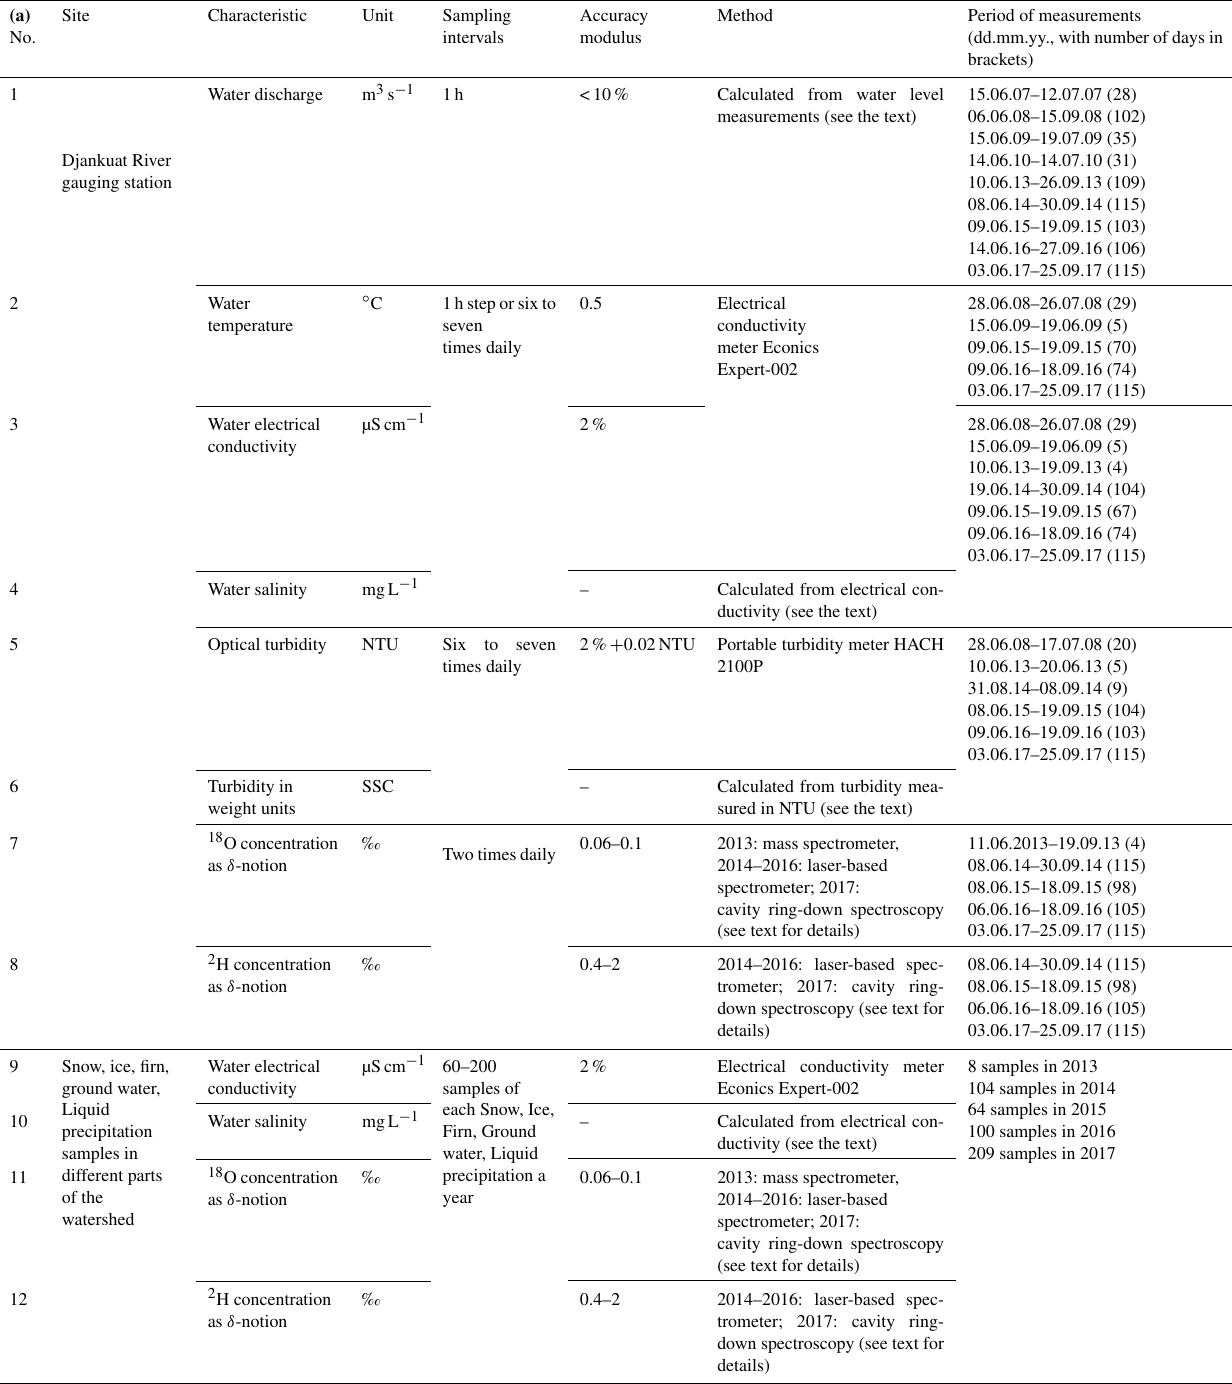
Table 2. (a) Hydrological characteristics measured in the Djankuat research basin and included in the database. (b) Glaciological charac- teristics measured in the Djankuat research basin and included in the database. (c) Meteorological characteristics measured in the Djankuat research basin and included in the